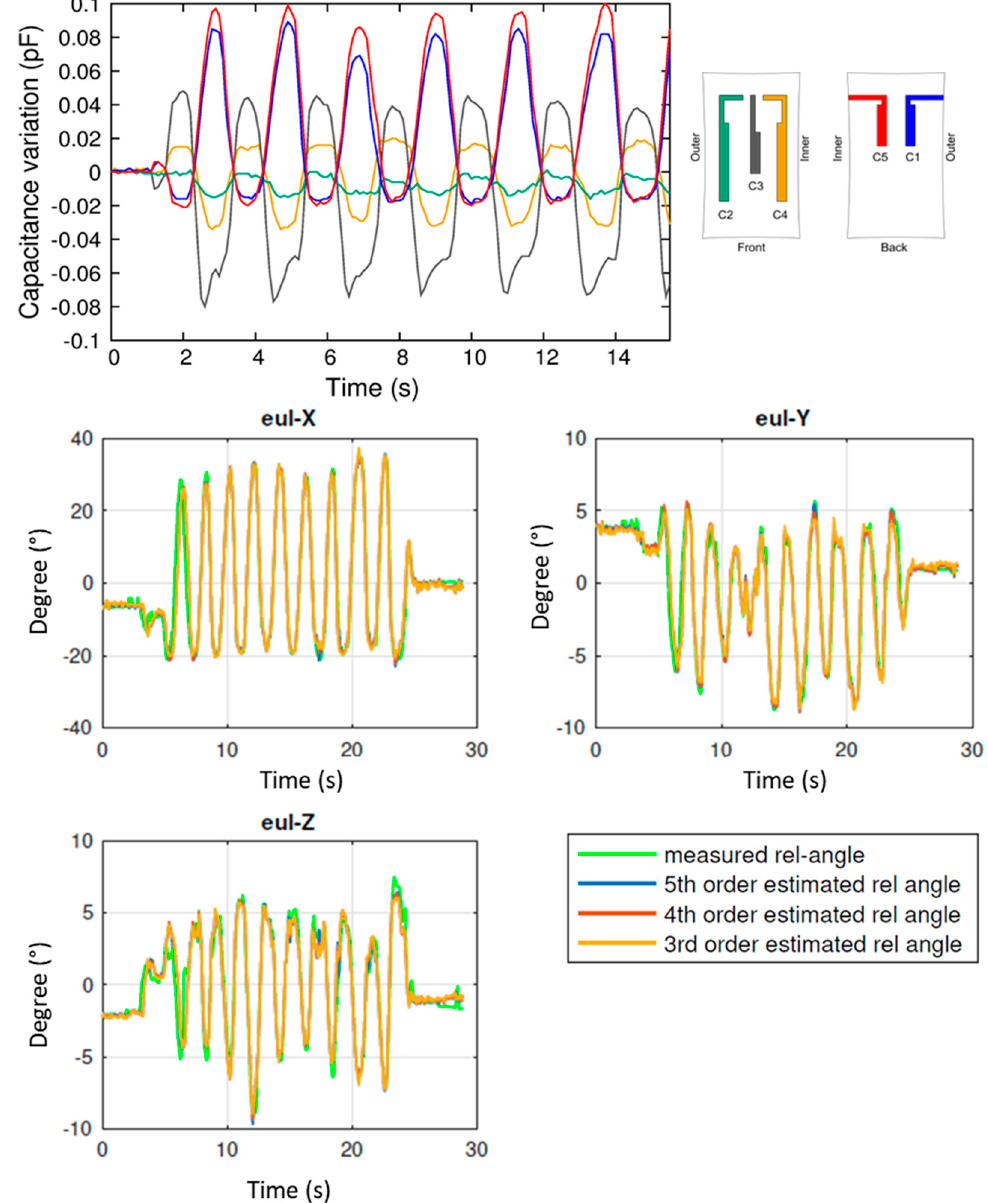
Figure 9. Results of the experimental analysis performed with the anklet during plantar dorsi/flexion. Top panel : raw capacitance variations of sensors C1 to C5. Bottom panels : reconstruction of the Euler angles (Eul-X, Eul-Y, Eul-Z), and comparison with the values (in green) measured by the optical tracking system.